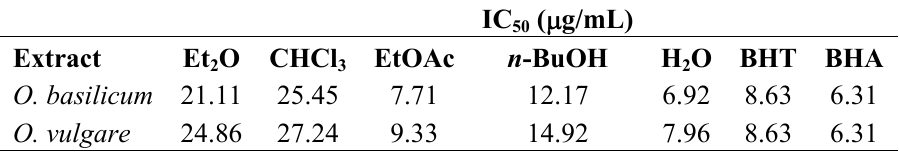
values ( μ g/mL) of the neutralization of NO radical with O. basilicum and Table 3. IC 50 O. vulgare